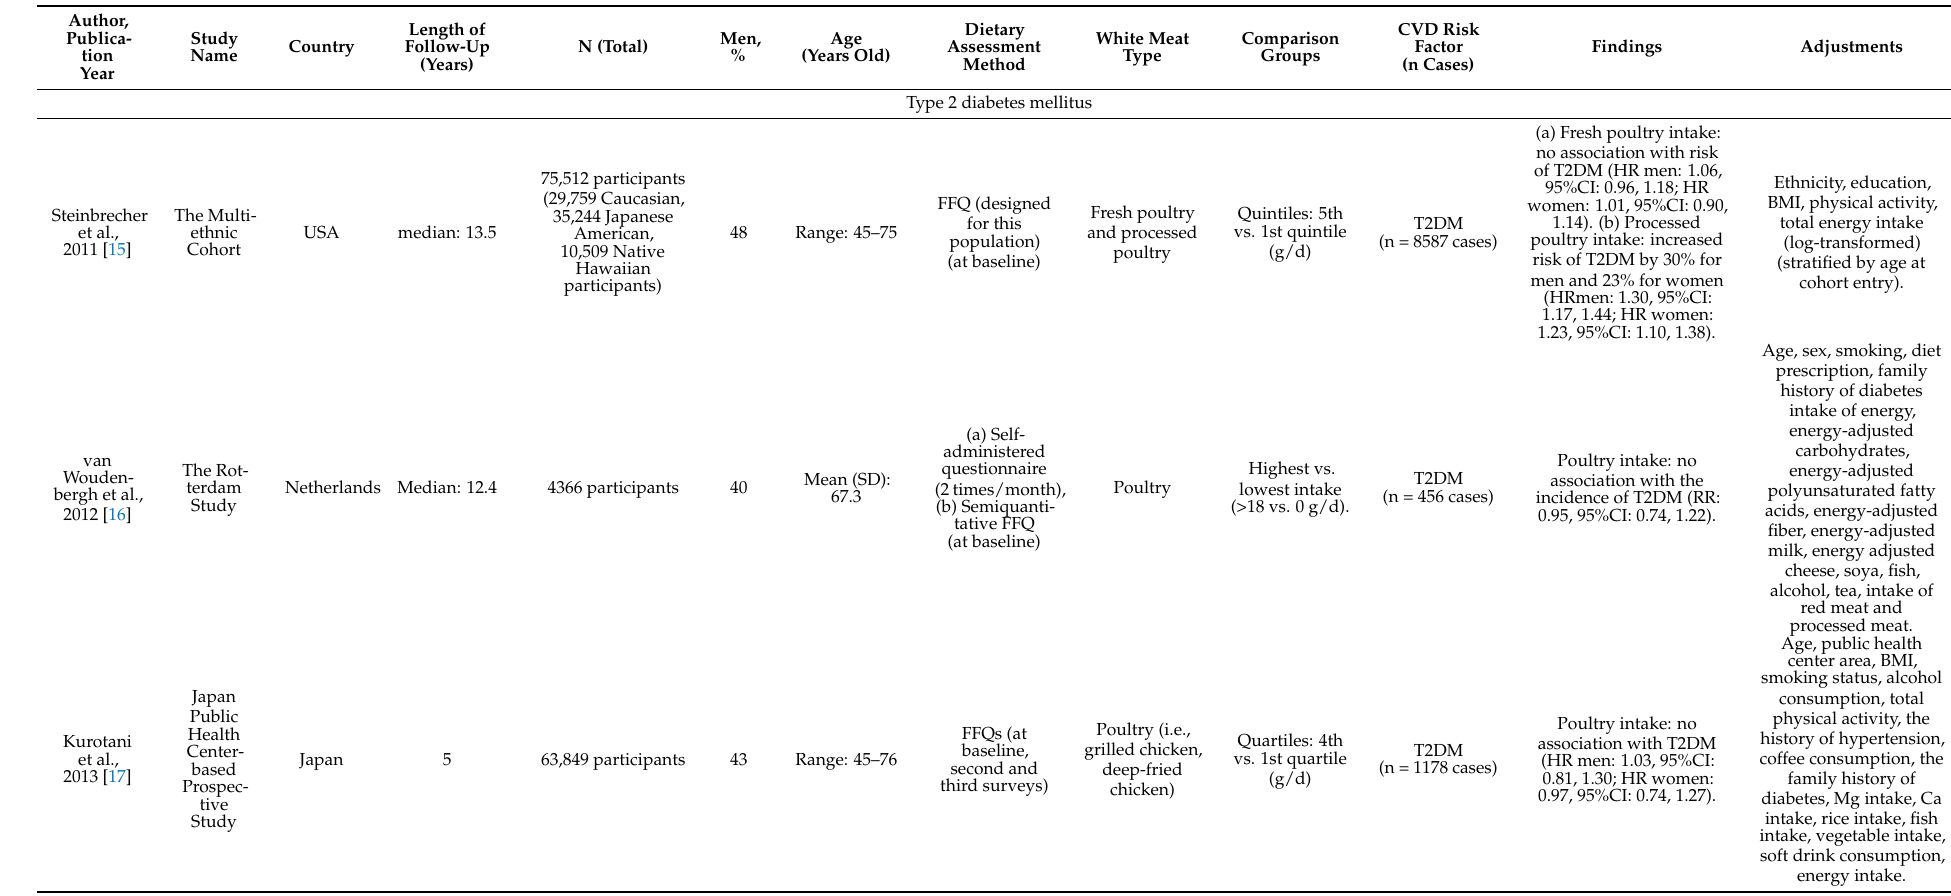
Table 2. Study characteristics of recent prospective cohort studies included in this